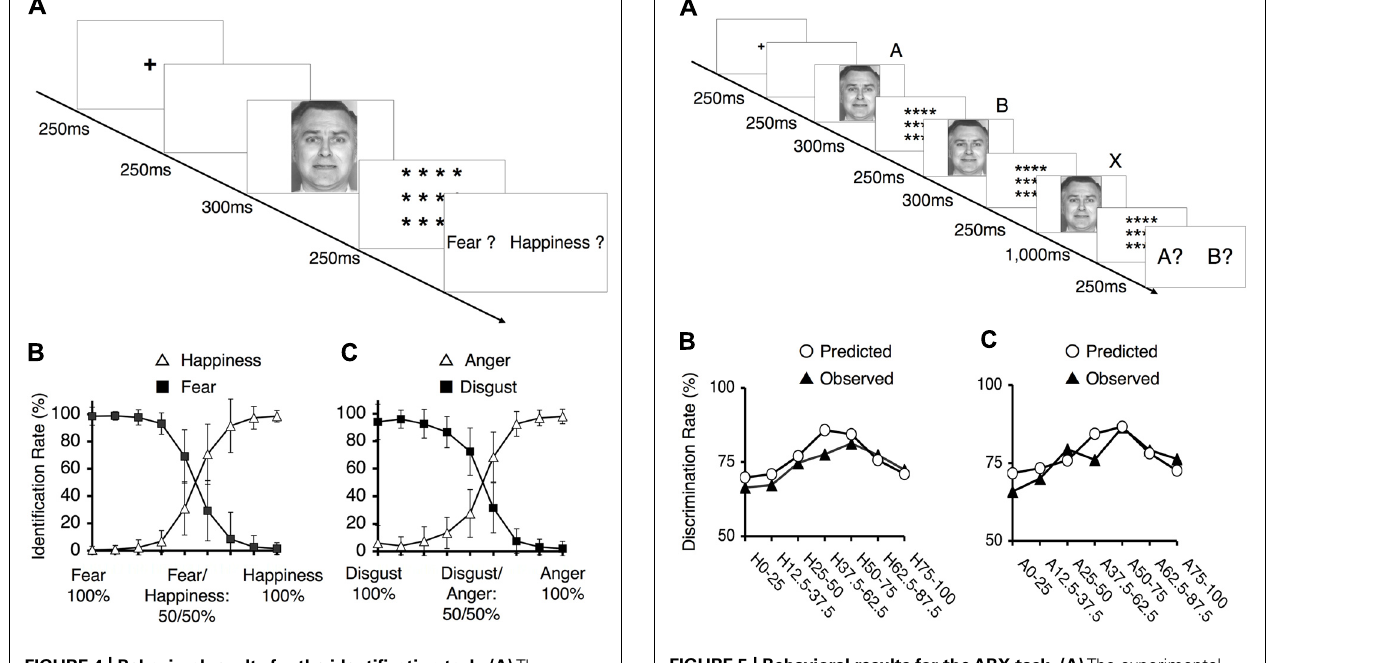
FIGURE 5 | Behavioral results for theABX task. (A) The experimental design of the ABX task. Subjects were asked to indicate whether the third face “X” matched the initial face “A” or the second face “B”. In each trial, the facial stimuli A and B differed by two steps on one of the examined continua; thus, there was always a 25% gap between this pair of faces (e.g., 100% happiness and 75% happiness), and seven potential pairs existed along each continuum.The third face, “X,” was always identical to either “A” or “B.” (B) The mean values of the observed discrimination rates and the predicted data for the happiness − fear continuum.The depicted rates were based on the frequency of correct responses in the ABX discrimination task.The labels indicate which pair of facial stimuli correspond to each point. For example, “H25–50” indicates a trial in which 25 and 50% happiness were presented as images A and B. (C) The mean values of the observed discrimination rates and the predicted data for the anger–disgust continuum.The labels indicate which pair of facial stimuli correspond to each point. For example, “A25 − 50” indicates a trial in which 25 and 50% anger were presented as images A and